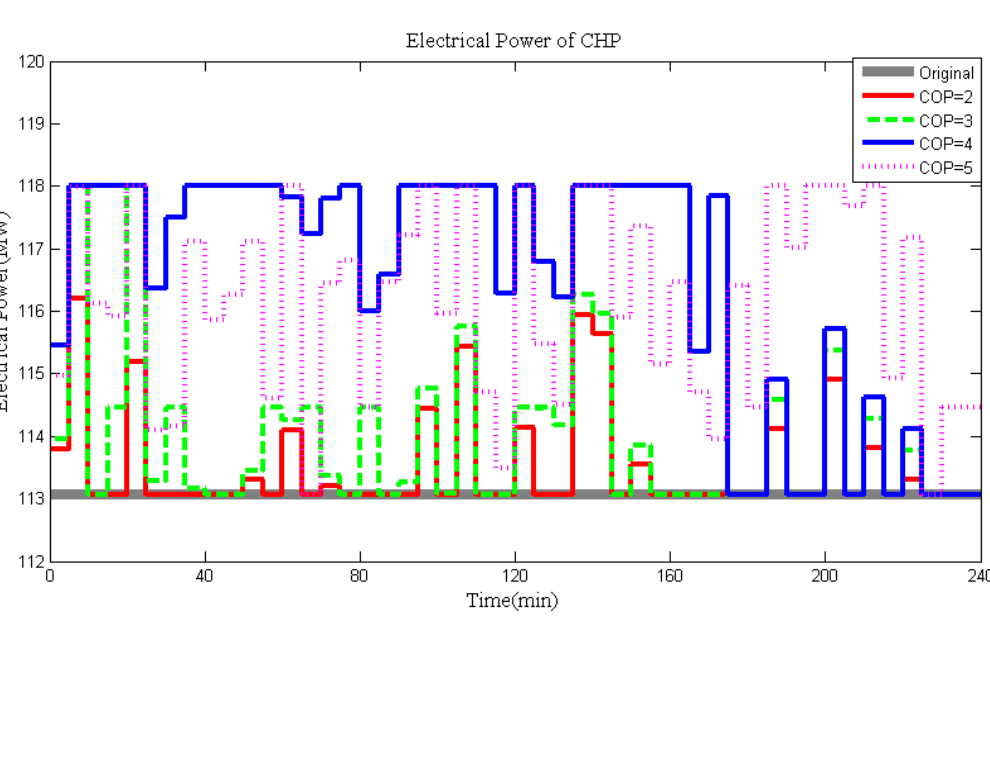
Figure 7. Adjustment of Electrical Power of